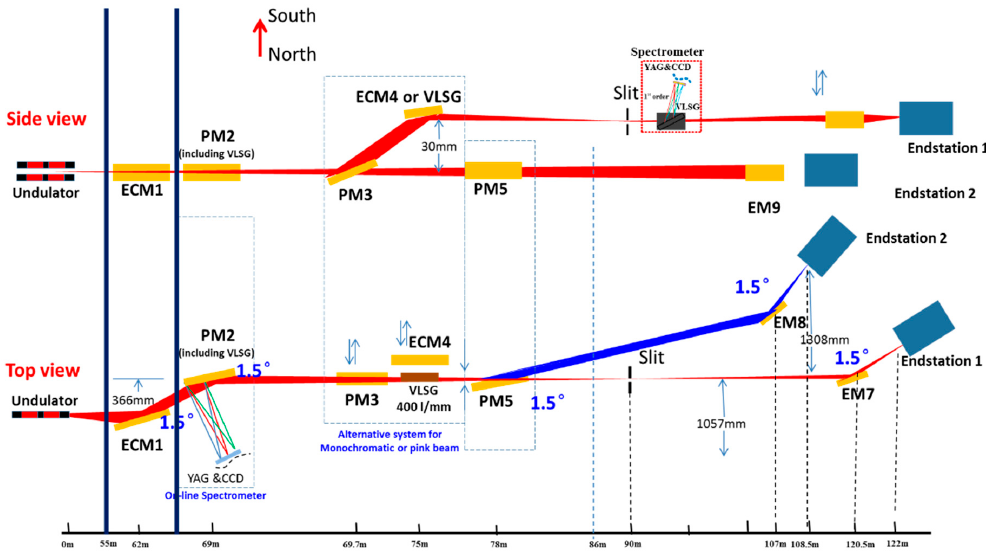
Figure 17. A typical beamline with two end-stations.